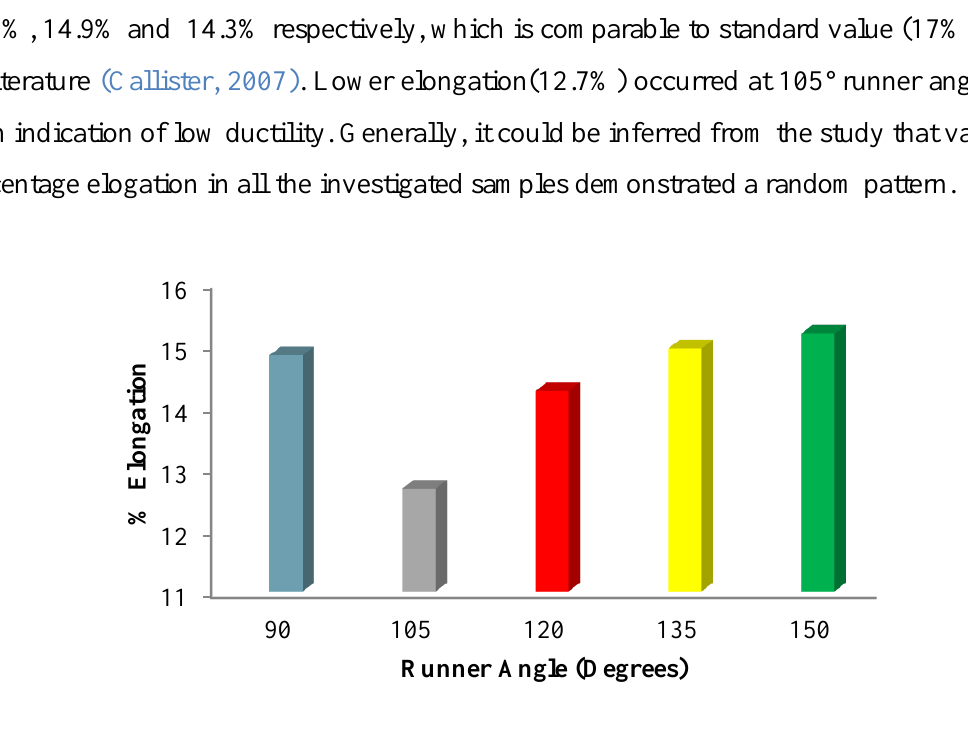
Fig. 9. Percent elongation for Al 6wt. % Cu, Al 5wt. % Zn alloy for varied runner